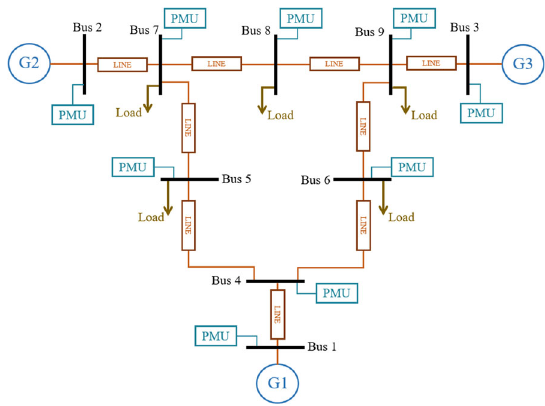
Fig. 8 Single Line Diagram of WSCC Nine Bus system